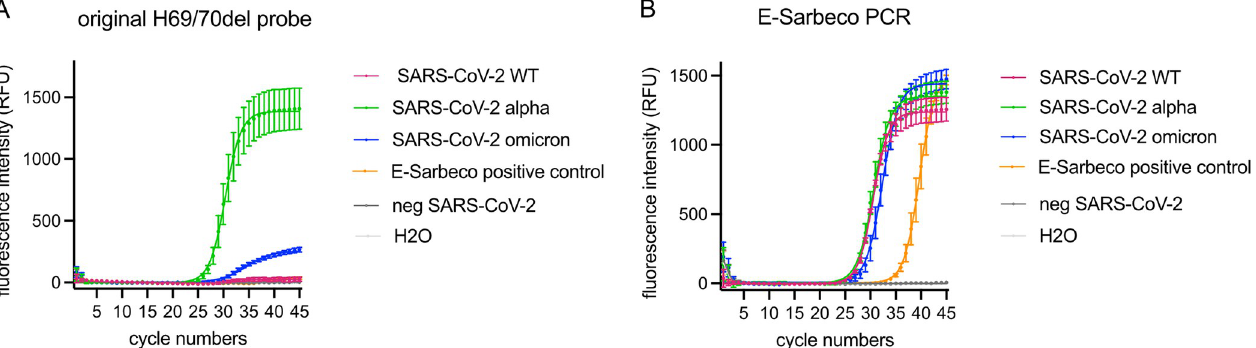
Fig 1. Detection of SARS-CoV-2 variants with the original Δ H69/V70 probe based on the SARS-CoV-2 alpha variant sequence. (A) Detection of SARS-CoV-2 variants with the original probe, including patient samples confirmed as SARS-CoV-2 Alpha variant as positive control and SARS-CoV-2 negative patient samples and a water as negative controls. (B) Samples were tested as multiplex RT-qPCRs; E-Sarbeco in parallel with the Δ H69/V70 RT-qPCR. Error bars in (A-B) indicate SEM for three biological replicates.